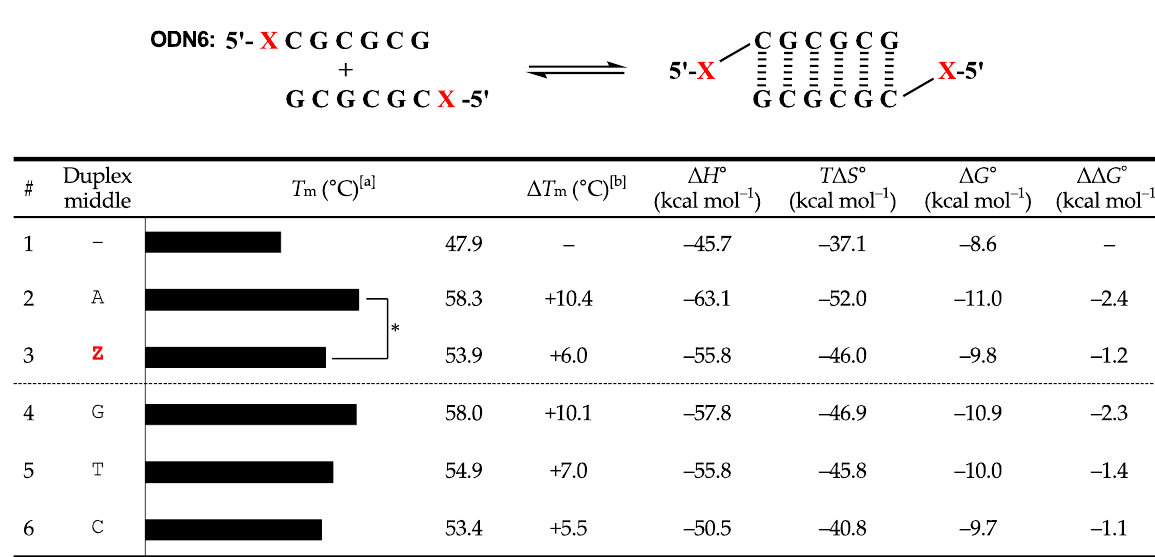
Figure 4. Stacking affinity of Z-base [a] . [a] All experiments were carried out in a buffer containing 1 M NaCl, 10 mM Na 2 HPO 4 , and 1 mM Na 2 EDTA (pH 7.0). Thermodynamic parameters were derived from the average values obtained from curve fitting and T m–1 versus ln(Ct/4) plots. T m was calculated at a strand concentration of 10 μM. [b] ∆ T m and ∆∆ G ° values were calculated based on the values of entry 1. * p < 0.05 by Student’s t -test.